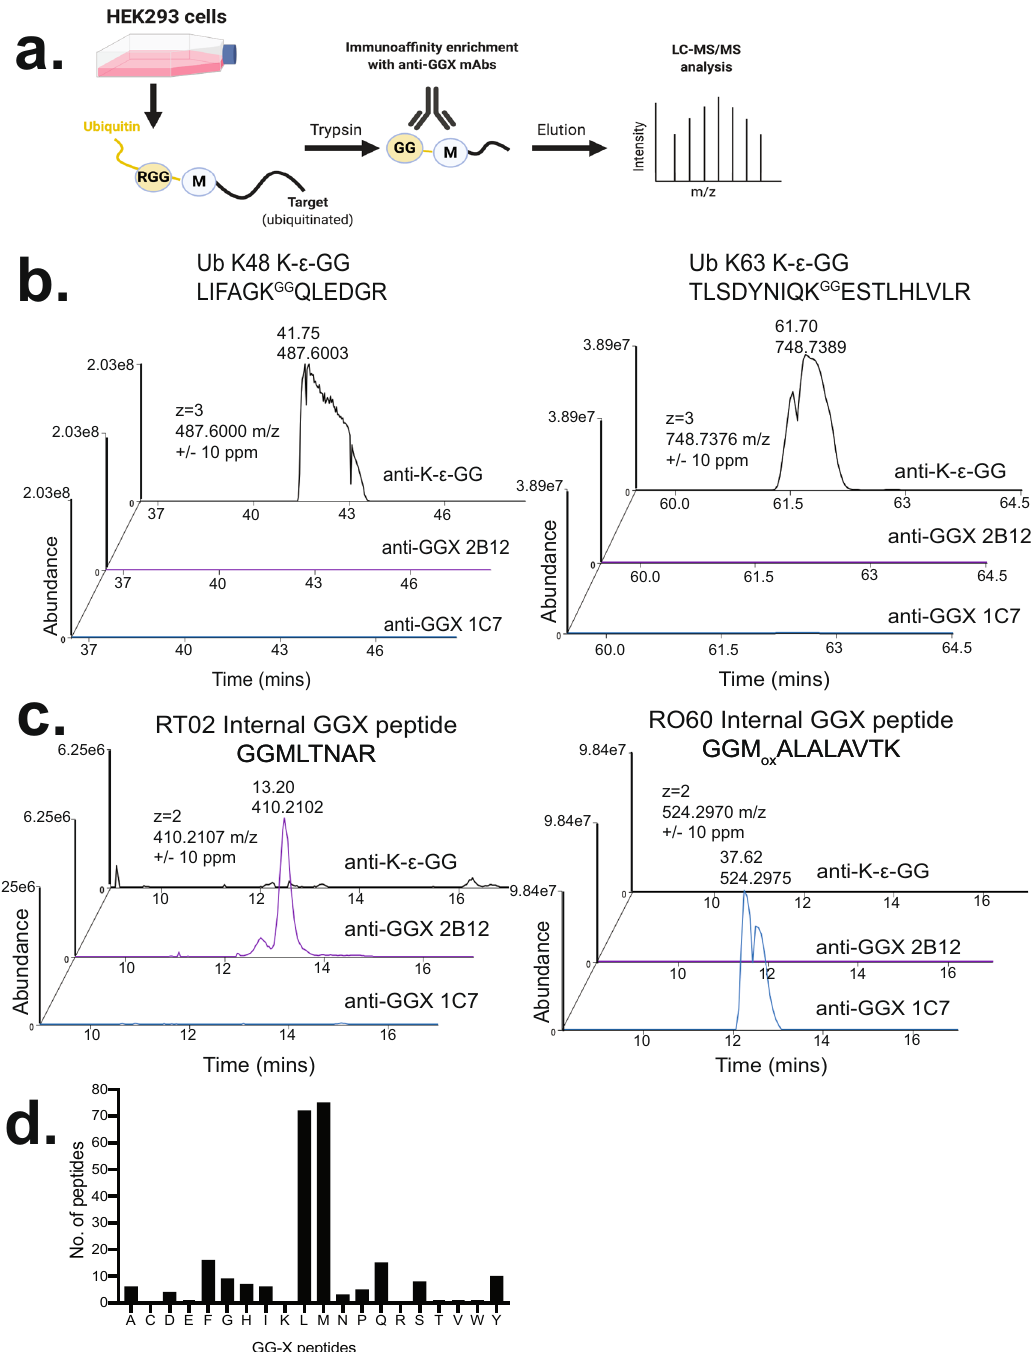
Fig. 3 Anti-GGX mAbs selectively IP GGX peptides and not K- ε -GG peptides. a Experimental schema depicting lysate preparation, trypsin proteolysis, immunoaf fi nity enrichment of GGX peptides followed by quantitative mass spectrometry (LC-MS/MS) analysis. Portions of ubiquitin are shown in yellow. b Extracted ion chromatograms (±10 ppm) for K48 and K63 K- ε -GG polyubiquitin chain linkage peptides LIFAGK GG QLEDGR and TLSDYNIQK GG ESTLHLVLR in anti-K- ε -GG, anti-GGX 2B12, and anti-GGX 1C7 immunoaf fi nity enrichment MS experiments. c Extracted ion chromatograms (±10 ppm) for internal GGX peptides GGMLTNAR and GGM ox ALALAVTK in anti-K- ε -GG, anti-GGX 2B12, and anti-GGX 1C7 immunoaf fi nity enrichment MS experiments. d Analysis of the X position of immunoaf fi nity enriched internal GGX peptides indicates a preferential enrichment for GGM and GGL peptides with other amino acids observed at lower